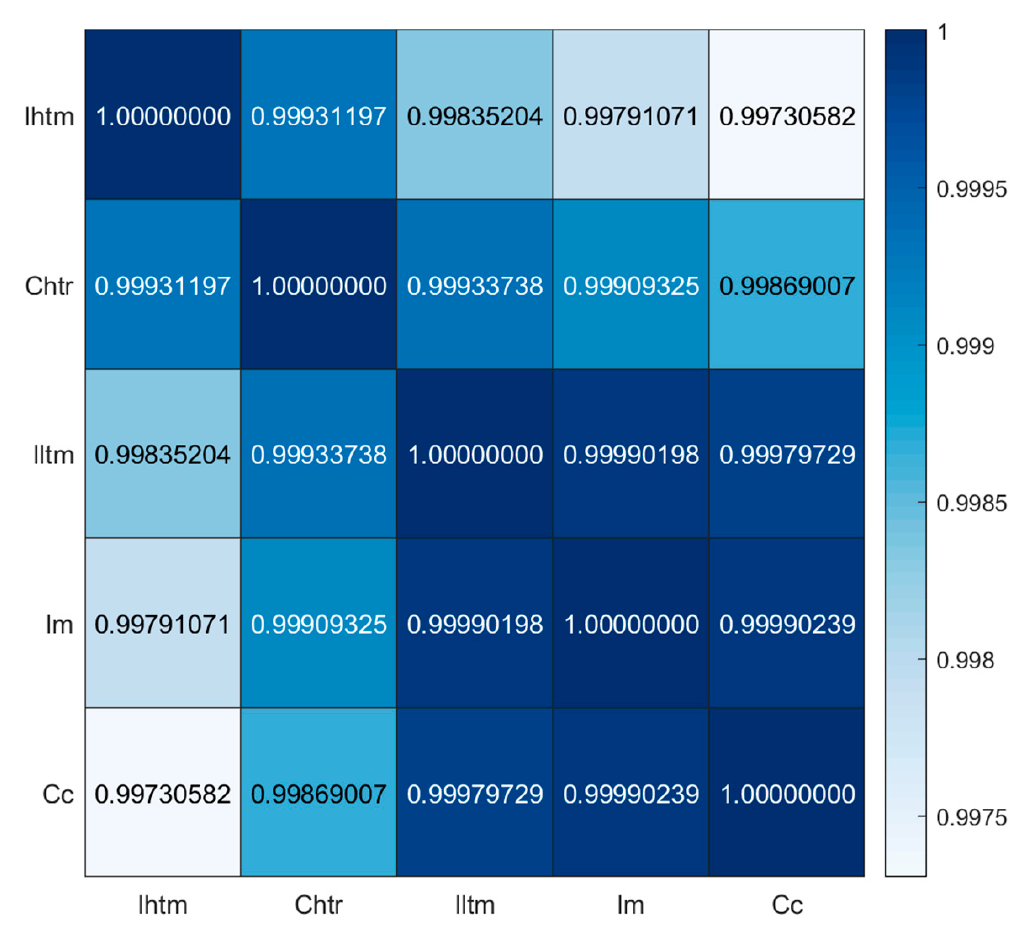
Figure 10. Pearson coe ffi cient of basalt unit classes.